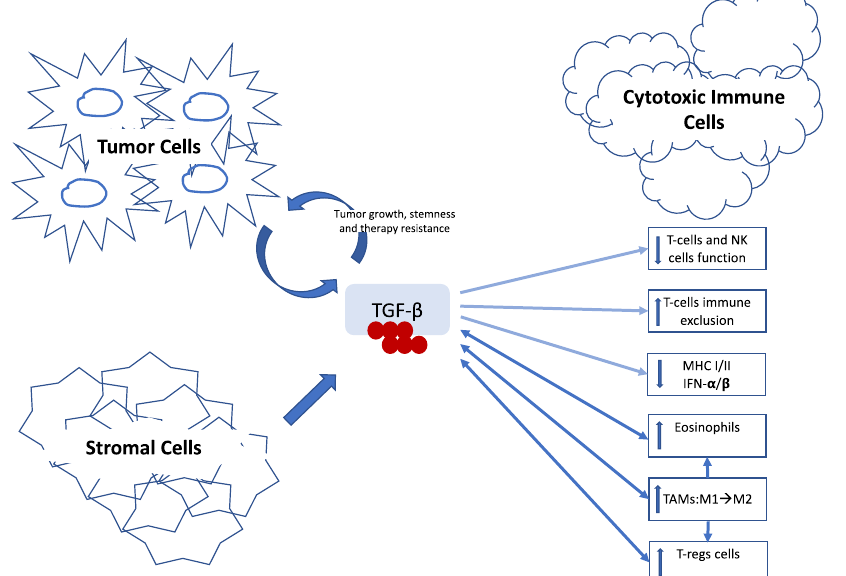
Fig. 5 Role of TGF- β in inducing immunosuppressive tumor immune microenvironment. Cartoon diagram of our potential hypothesis showing the impact of TGF- β on promoting immunosuppressive tumor immune microenvironment and potential interaction with other immune cells including tumor-associated macrophages, eosinophils, and T-regulatory